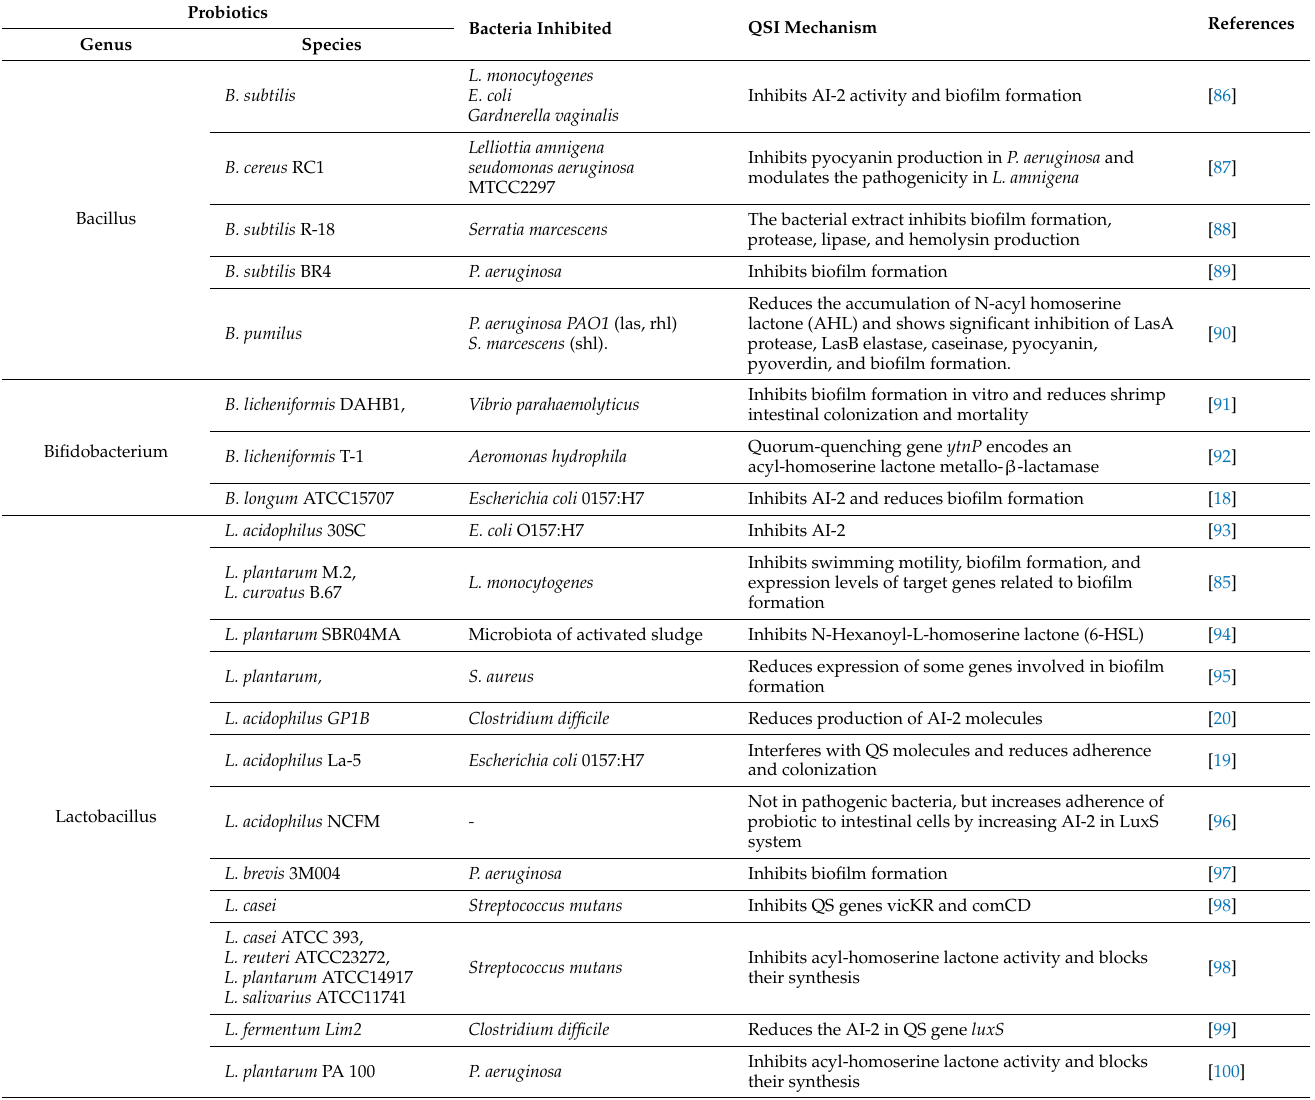
Table 1. Some probiotic strains with QQ activity and the mechanism involved.